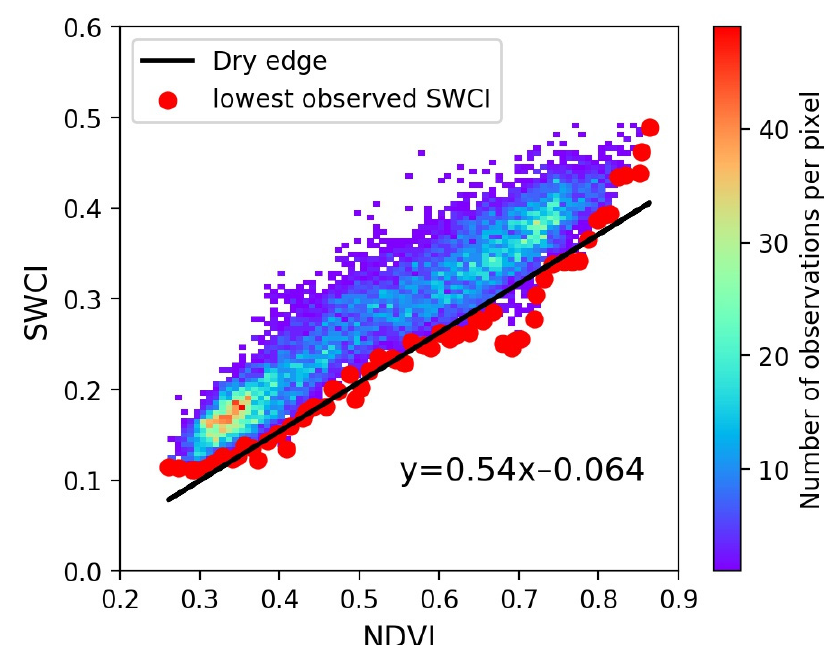
Figure 6. Density scatter plot of weekly SWCI vs. NDVI values from sixty study sampling windows, the color represents the number of observations per pixel, the red color points are the lowest observed SWCI in the bins of NDVI. The line (Dry edge) is the best-fitted regression line to these lowest SWCI points. The equation of the line is shown in the figure.